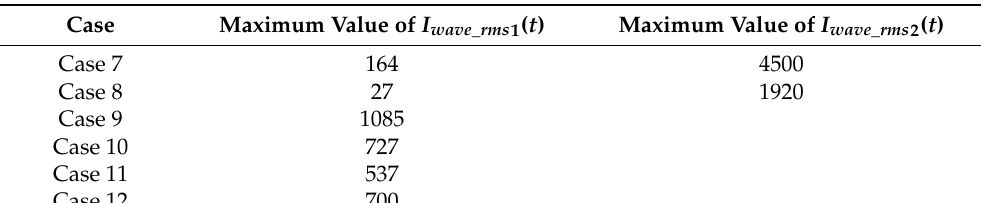
Table 5. Maximum value of I wave_rms 1 ( t ) and I wave_rms 2 ( t ) at Cases 7–12.